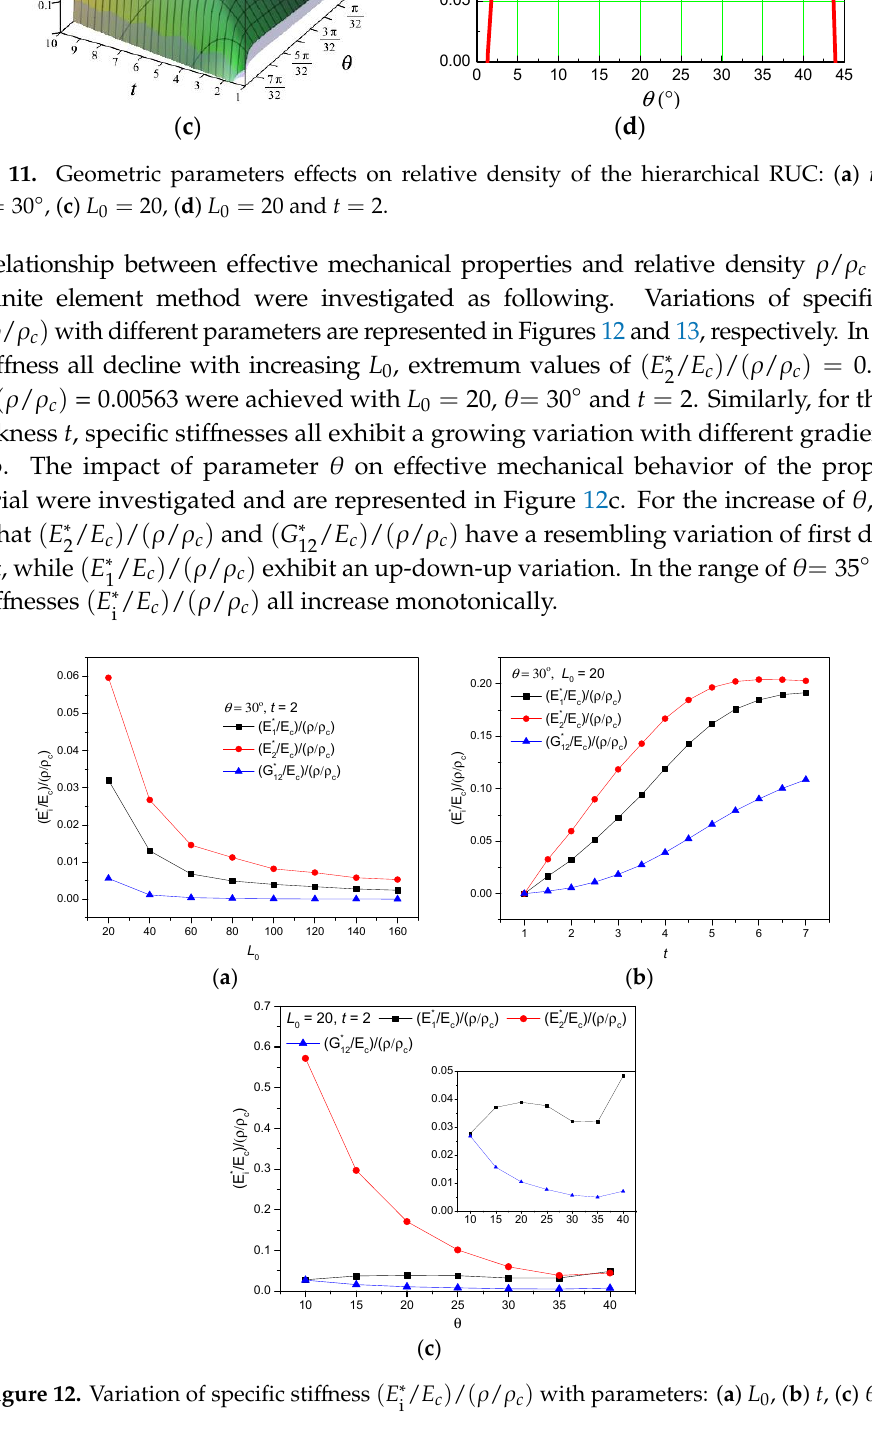
θ t , ( c ) . L , ( b ) 0 θ for various = 20 L 0